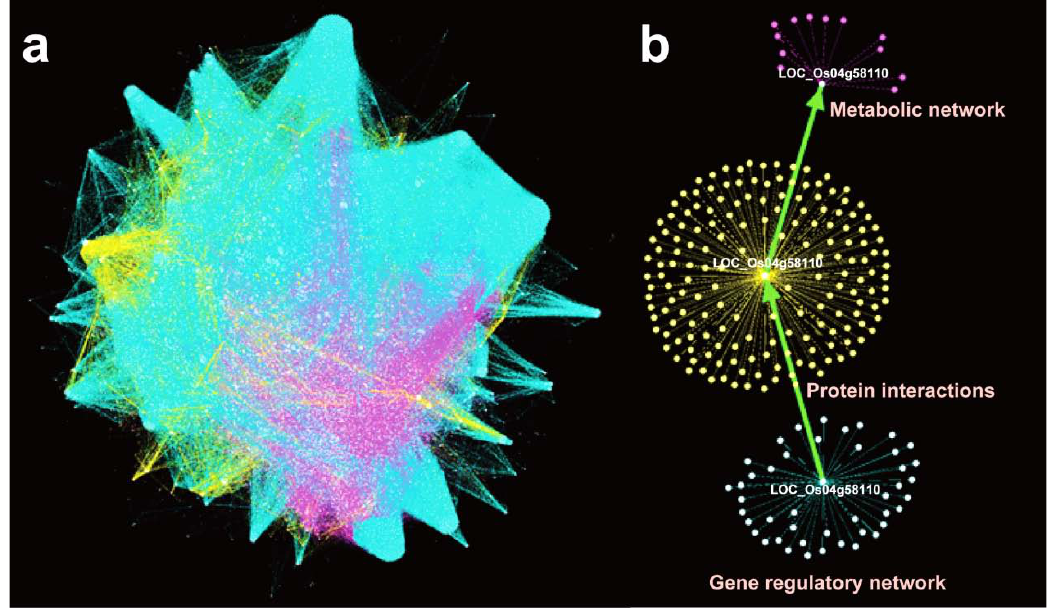
Figure 3: The genome-scale multi-level network of rice; (a) overview of the genome-scale multiple level network of rice visualized by Gephi (http://www.gephi.org), blue color denotes the gene regulations, yellow denotes the protein-protein interactions and pink shows the protein- metabolite interactions; (b) view of gene centric (LOC_Os04g58110) multi-level